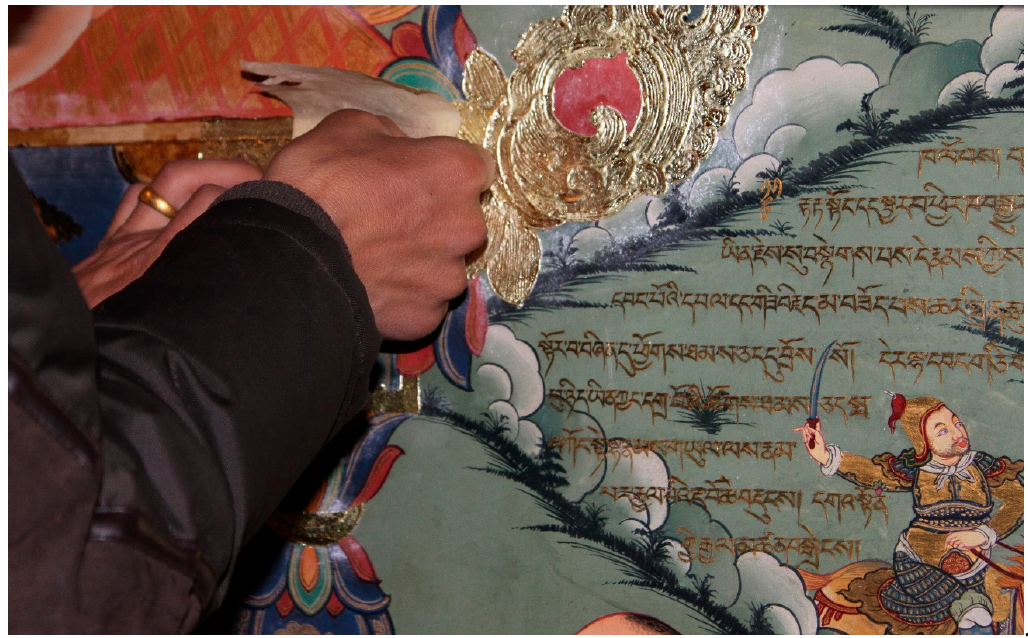
Figure 3. A painter gilding his wall painting, Ramoche Temple, Lhasa, Tibet (photo C. Bellini 2003).